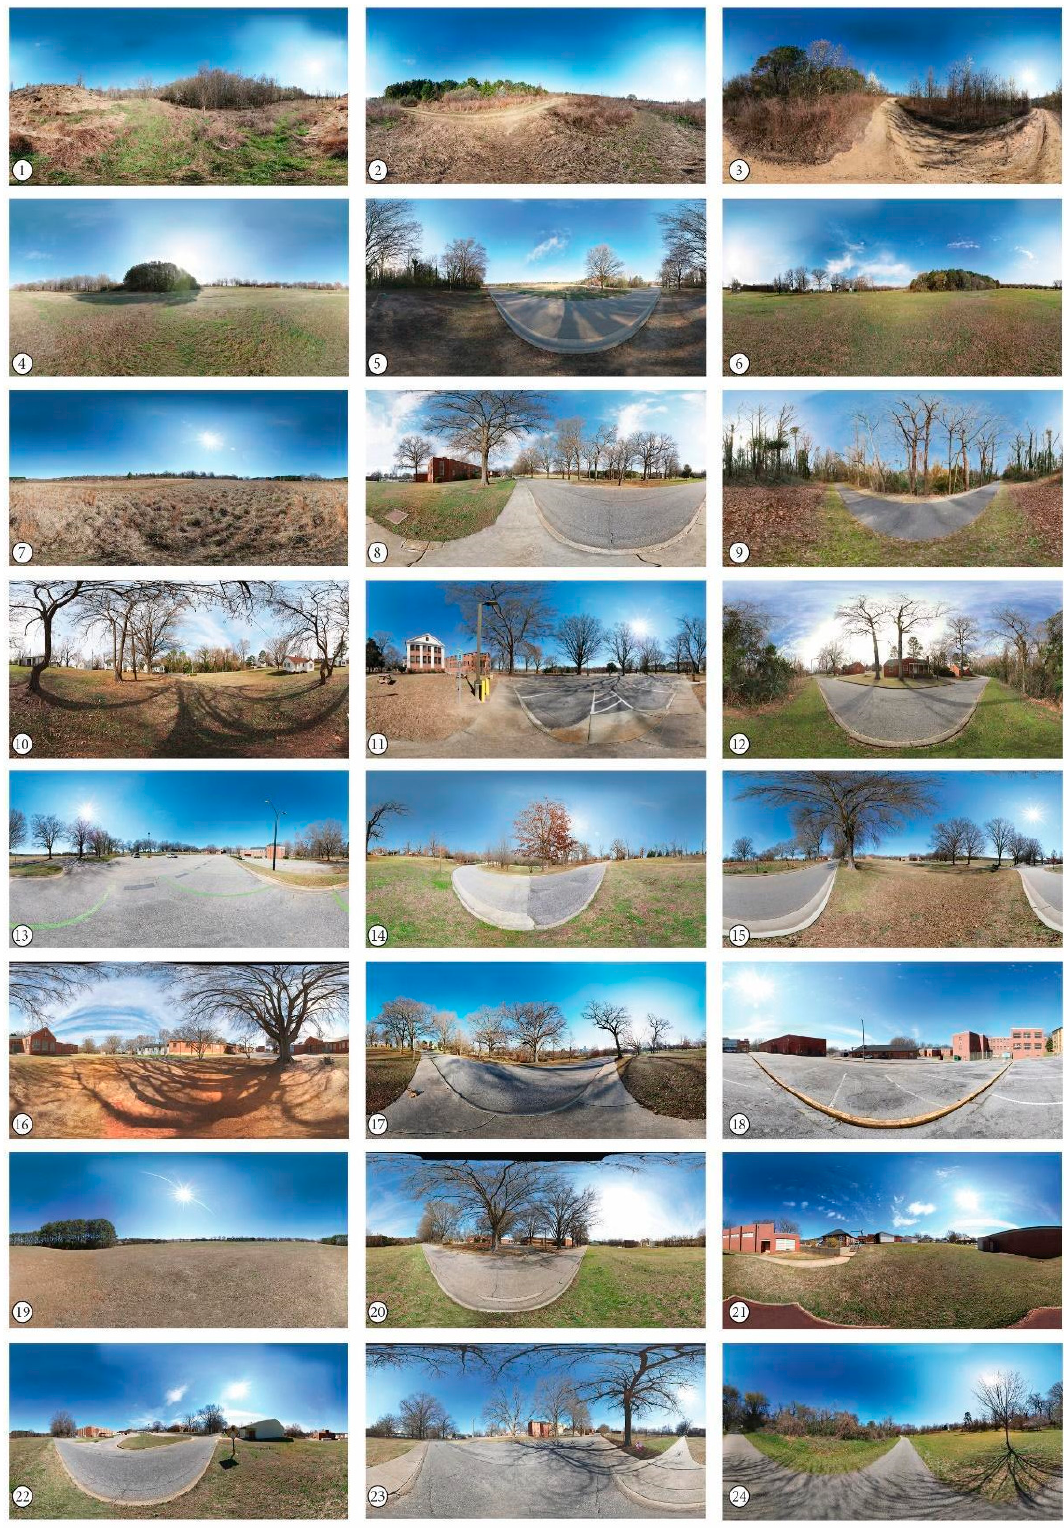
Figure 6. Equirectangular images used in an immersive virtual environment (IVE) survey. Note: The images have spherical distortion.